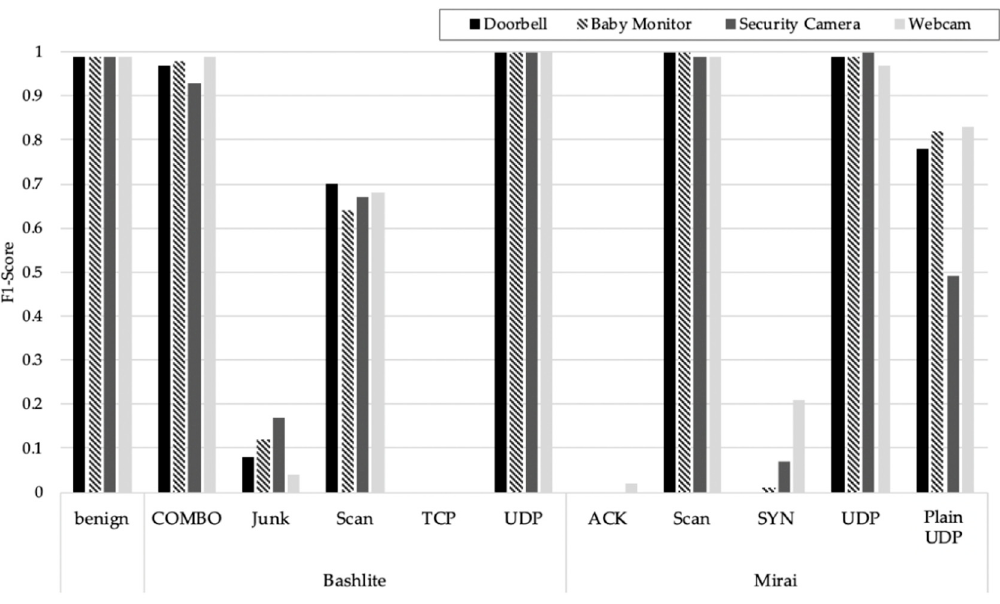
Figure 3. The F1-score of each attack type in naïve Bayes-based model.